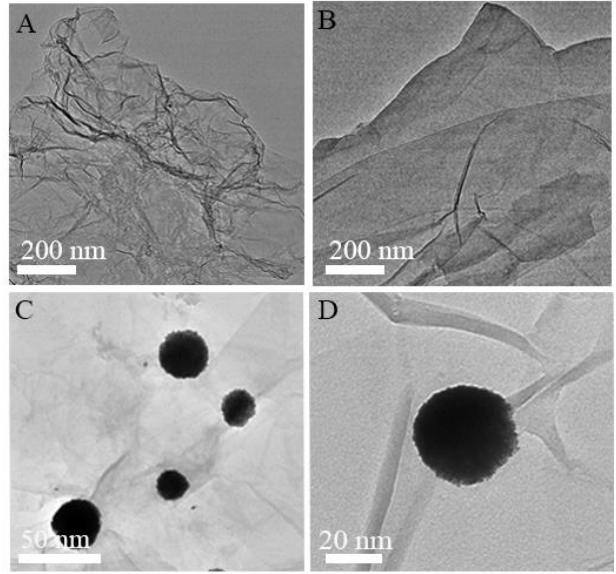
Figure 1. Transmission electron microscopy (TEM) images of ( A ) RGO, ( B ) PEI-functionalized RGO, and ( C , D ) Au@Pt-PEI-RGO under different magnification. Nanomaterials 2020 , 10 , x FOR PEER REVIEW